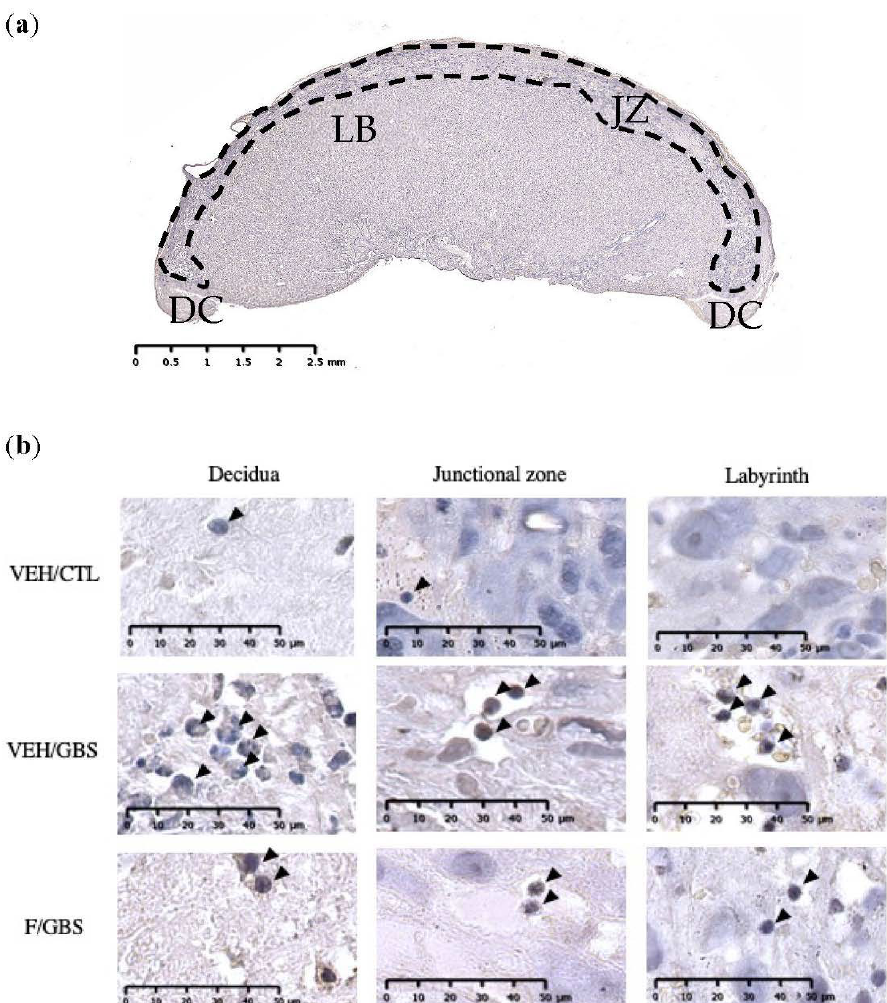
Figure 4. Flutamide reduced the infiltration of PMN cells in GBS infected placental compartments. ( a ) Coronal section of placental compartments showing the maternal (decidua, DC), maternofetal zone (junctional zone, JZ), and fetal (labyrinth, LB) compartments. ( b ) PMN infiltrations (circular in shape, stained dark purple/brown staining, black arrowheads) in DC, JZ and LB compartments of the placenta.